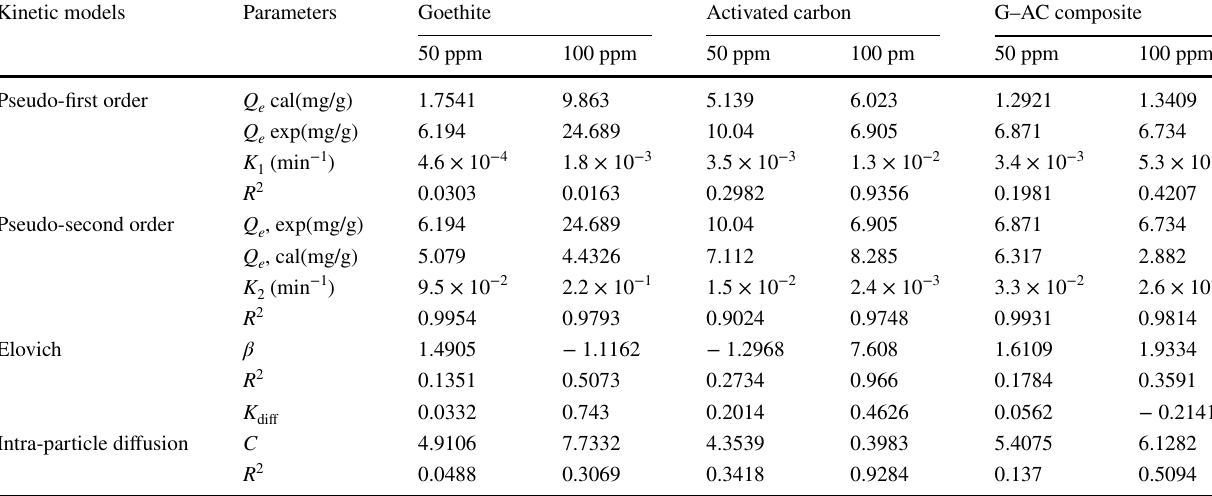
Table 3 Kinetic parameters for various Cr(VI) adsorption